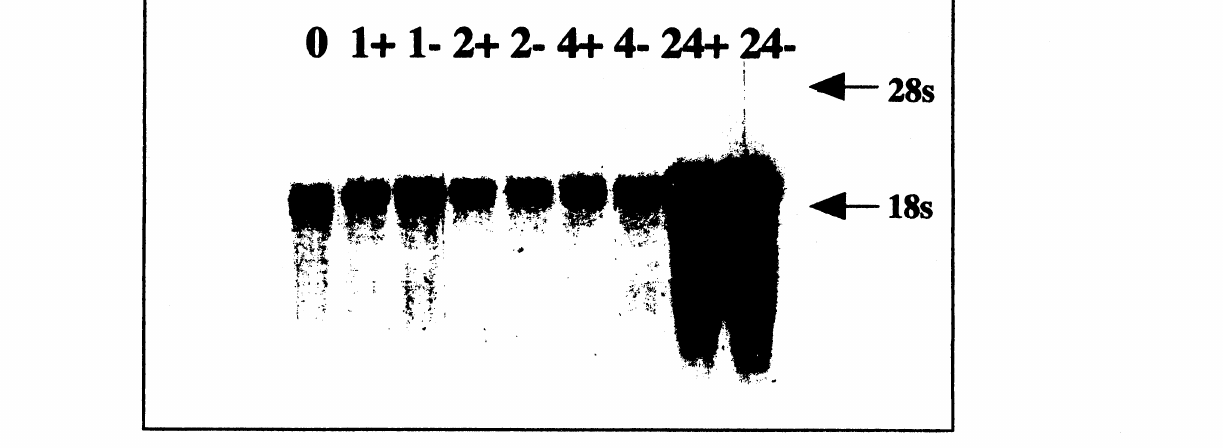
Fig. 7. Lack of effect of LPS exposure on HI9 mRNA expression in human cytotrophoblast cells.